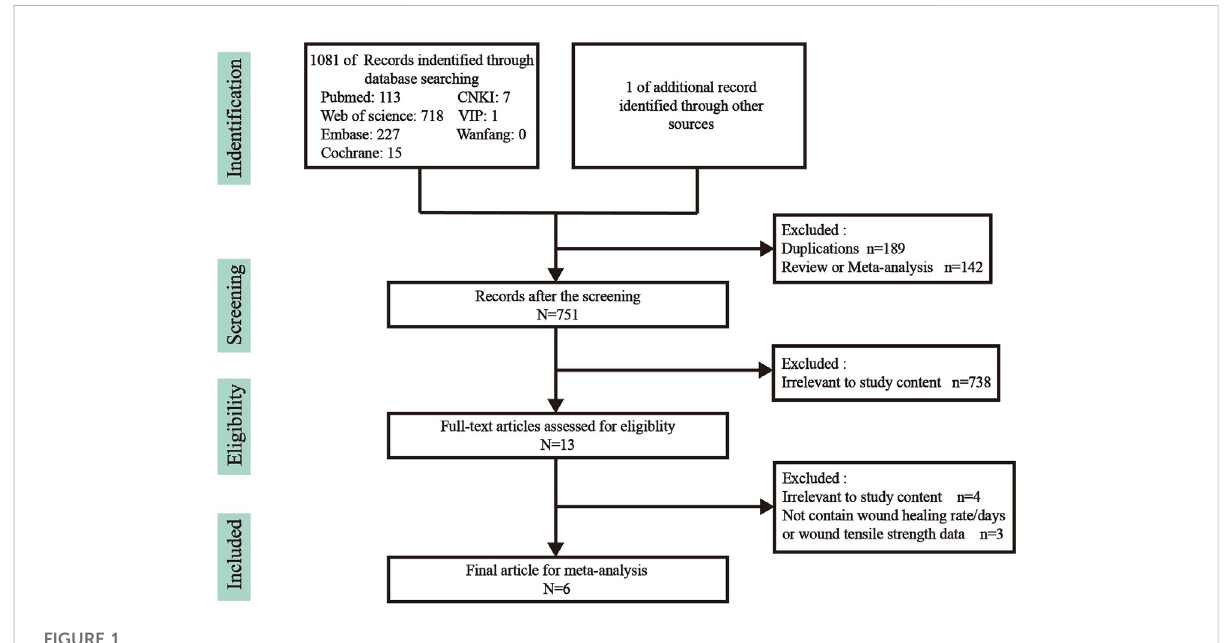
FIGURE 1 Flowchart of study